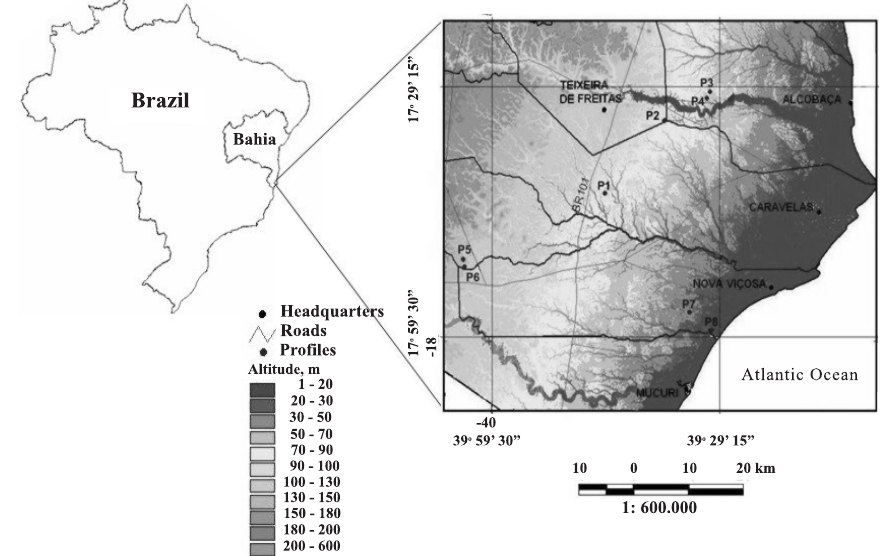
Figure 1. Location of study area showing the profiles P1, P2, P3, P4, P5, P6, P7 and